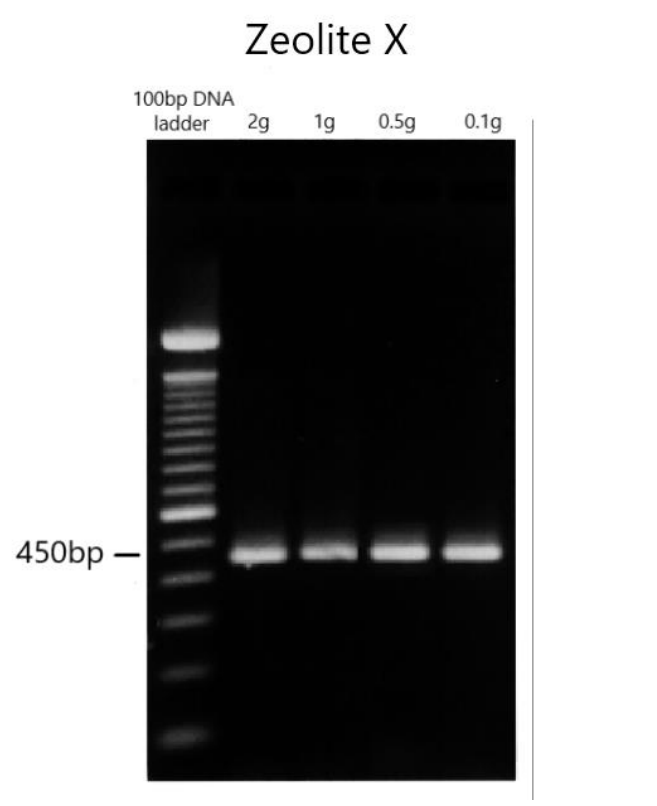
Table 2. Overview of C. parvum -positive Neocaridina shrimp after filtration of oocysts from